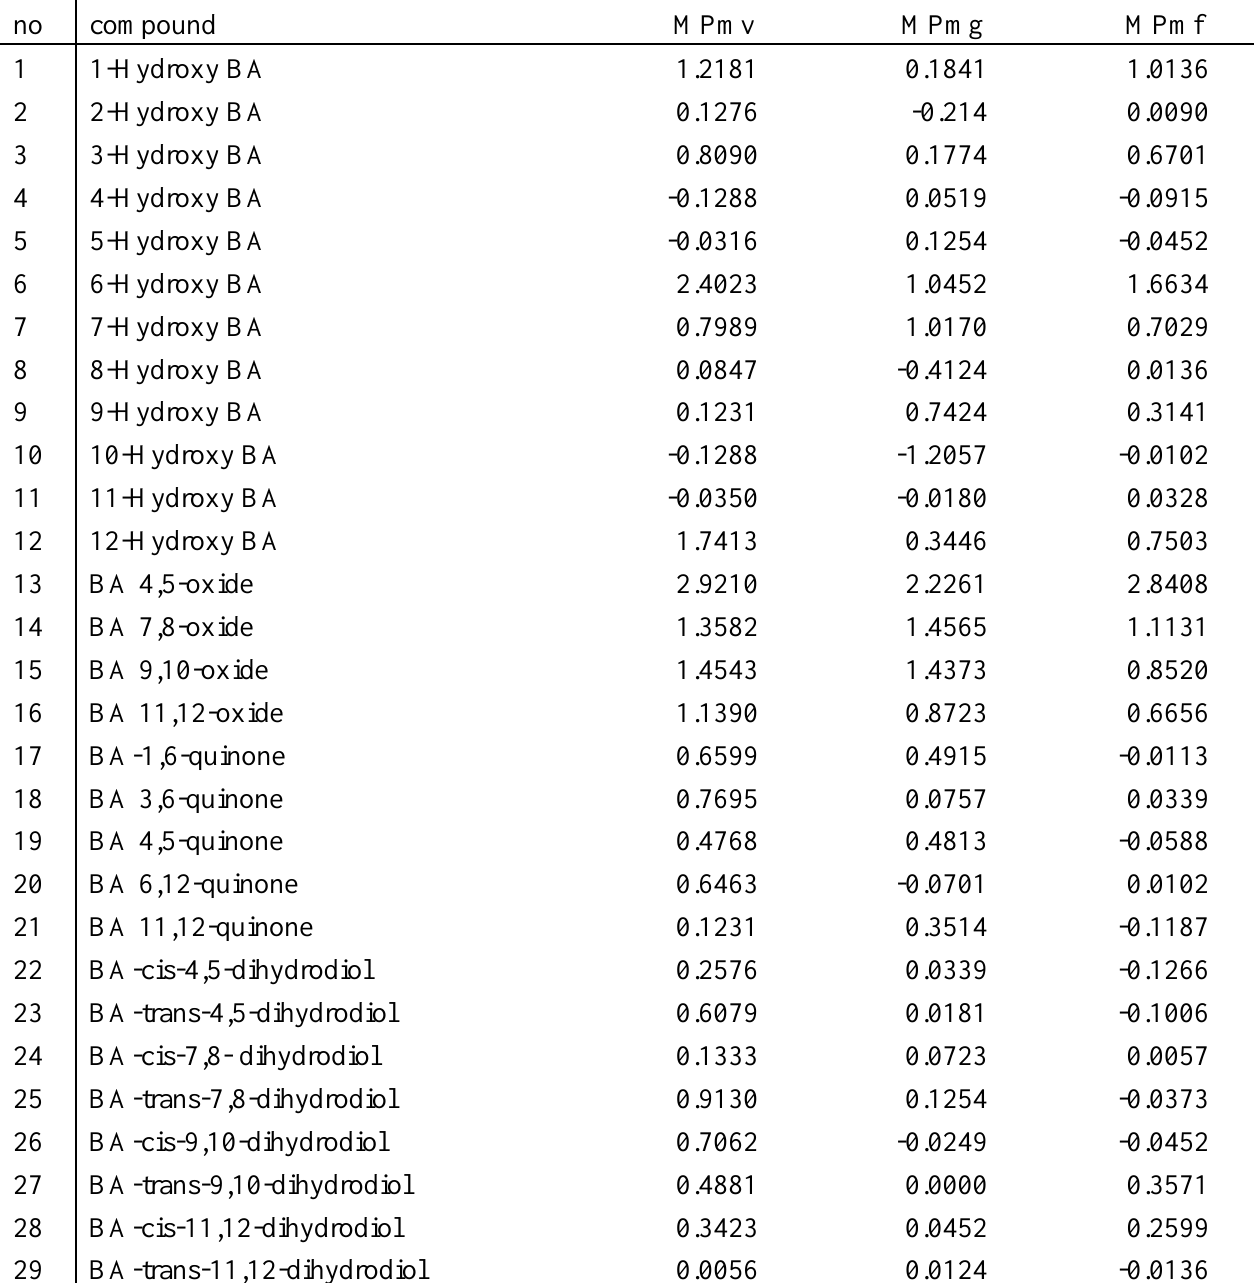
Table 1. Mutagenic potency data of BA derivatives in Mycobacterium